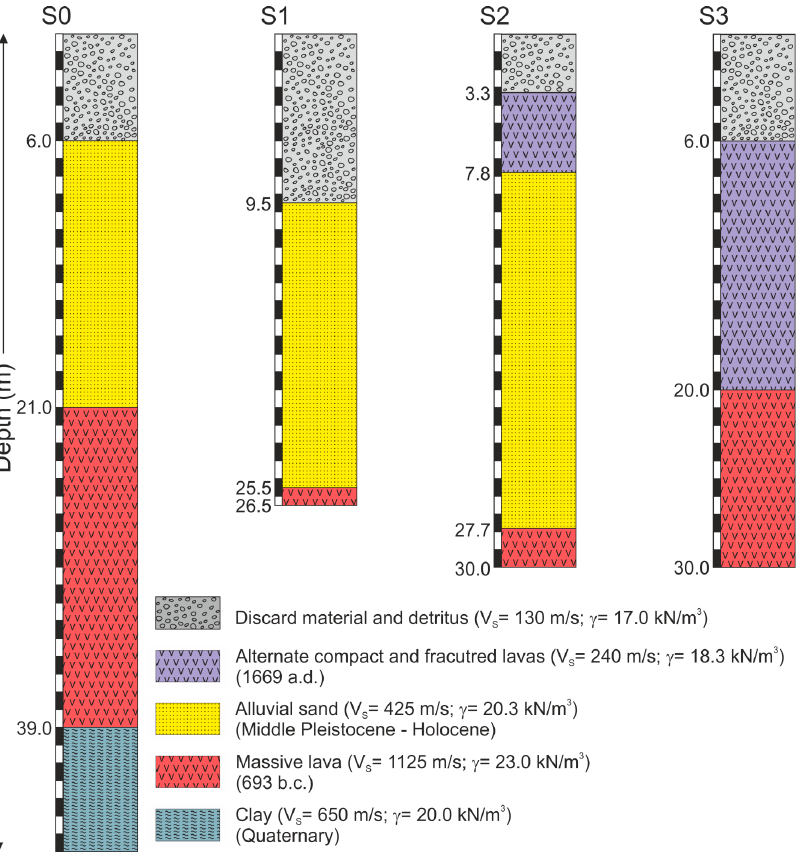
Figure 2. Litho-stratigraphic sequences from boreholes data (see Figure 1b for the